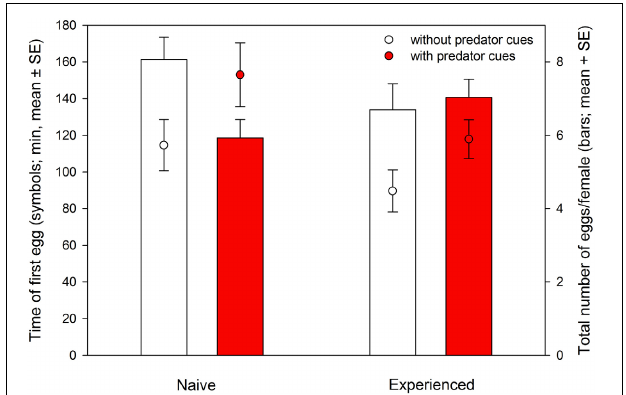
FIGURE 1 | Time of the first egg laid (symbols) and total oviposition within 24h (bars) of predator-naïve and -experienced spider mite females placed singly on leaf discs with or without predatory mite cues.